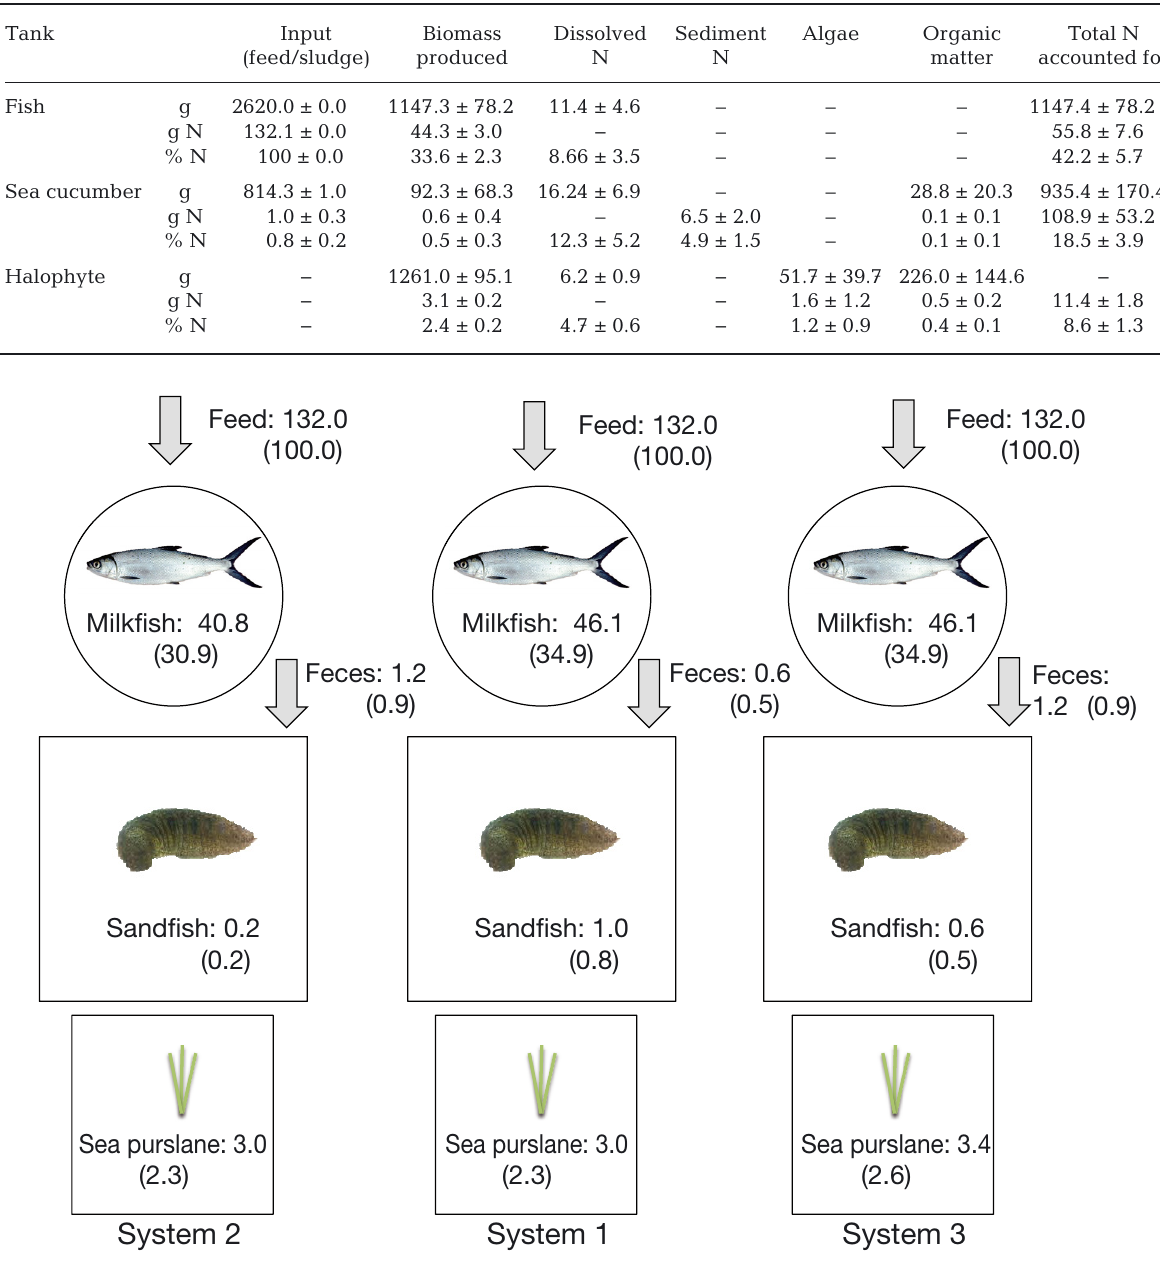
Fig. 7. Conceptual representation of the 3 experimental RAS, each including a milkfish tank, sea cucumber tank and hydro- ponic sea purslane tank. Numbers indicate the N content (g) of the different compartments, with the corresponding % N relative to the input (feed) in